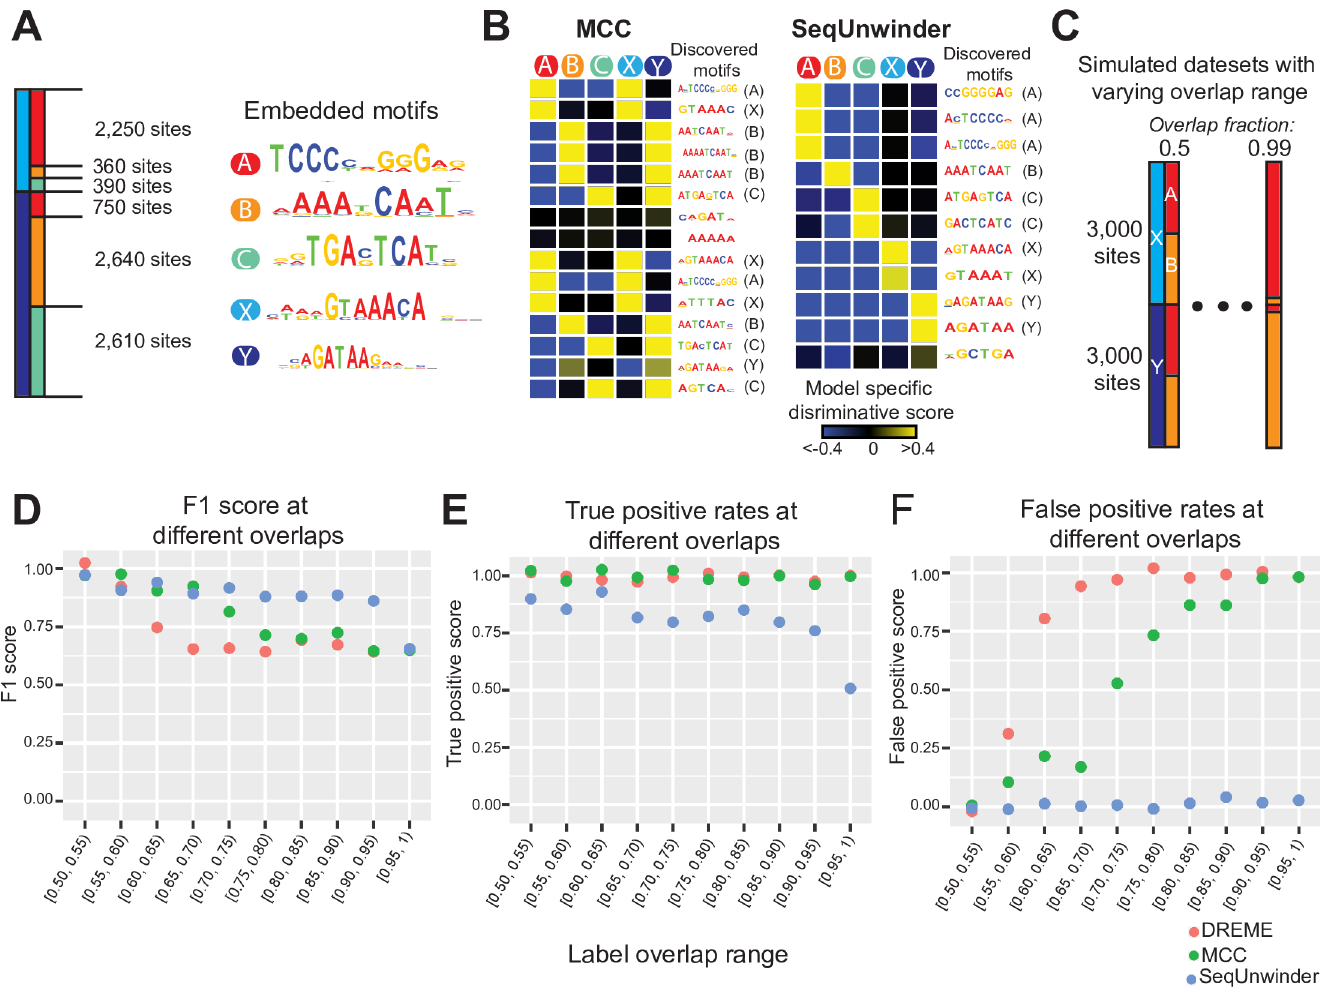
Fig 2. Performanceof SeqUnwinder on simulated datasets. (A) 9000 simulatedgenomicsites with correspondingmotif associations. (B) Label- specific scores for all de novo motifs identified using MCC (left) and SeqUnwinder (right) models on simulatedgenomicsites in “A”. For consistency across figures, we fix the color saturation values to -0.4 and 0.4 (C) Schematic showing100 genomicdatasets with 6000 genomicsites and varyingdegreesof label overlap rangingfrom 0.5 to 0.99. (D) Performance of MCC (multi-class logistic classifier), DREME, and SeqUnwinder on simulateddatasets in “C”, measuredusing the F1-score, (E) true positive rates, and (F) false positive